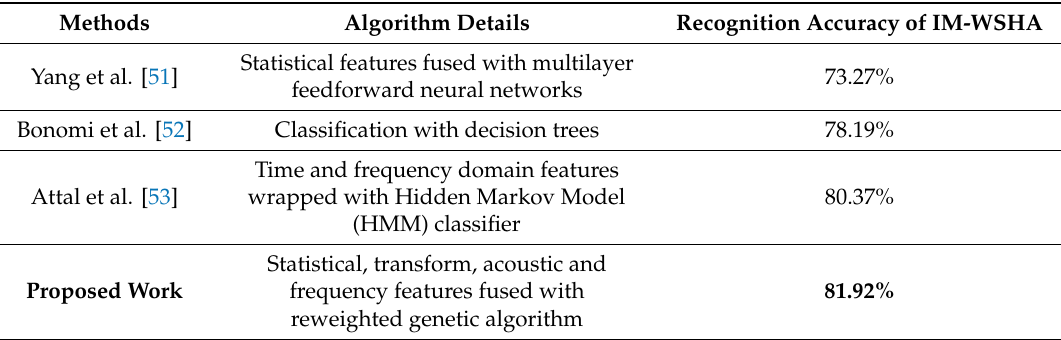
Table 3. Physical activity recognition accuracy comparison of the proposed method with other state-of-the-art methods over IM-WSHA inertial